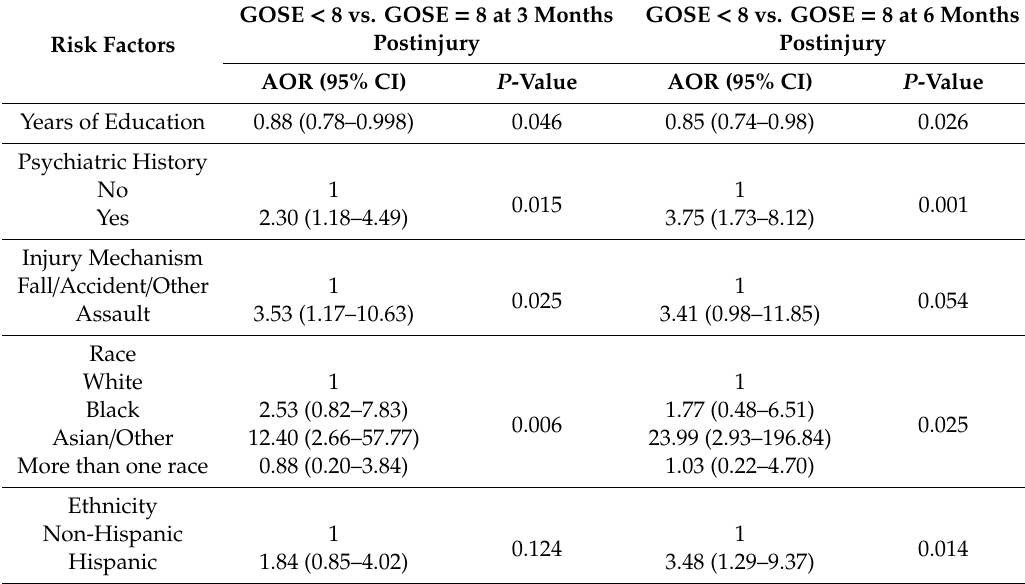
Table 2. Multivariable analysis of Risk Factors for 3- and 6-month functional deficits (GOSE <